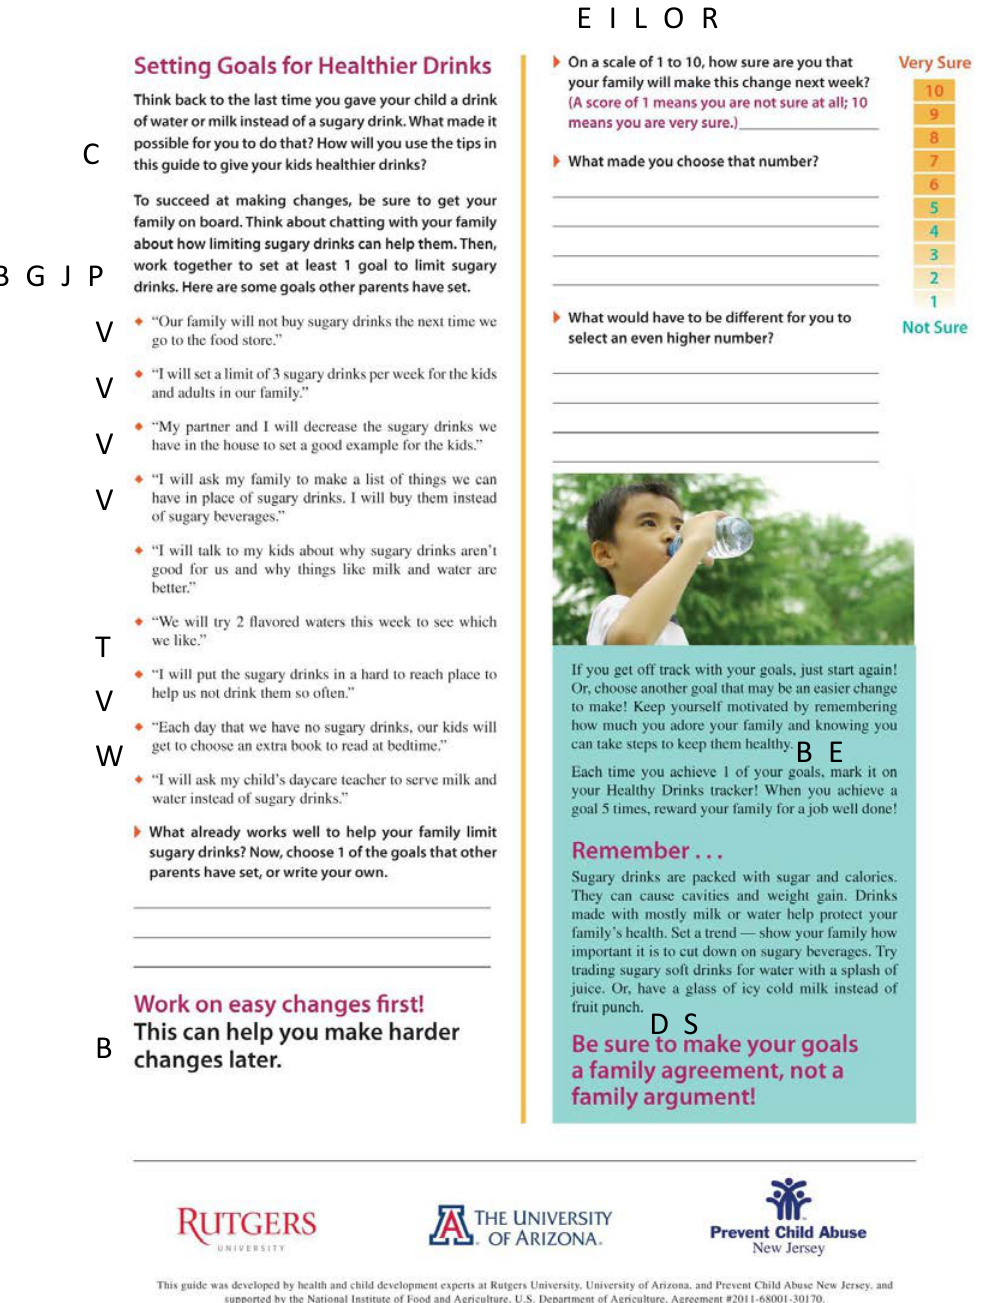
Figure 2. Best Drinks Guide as Example Showing Use of Social Cognitive Theory, Faith’s Core Behavior Change Strategies, and Motivational Interviewing Strategies. Note: The letters in black boxes correspond to the strategies in Table 3.